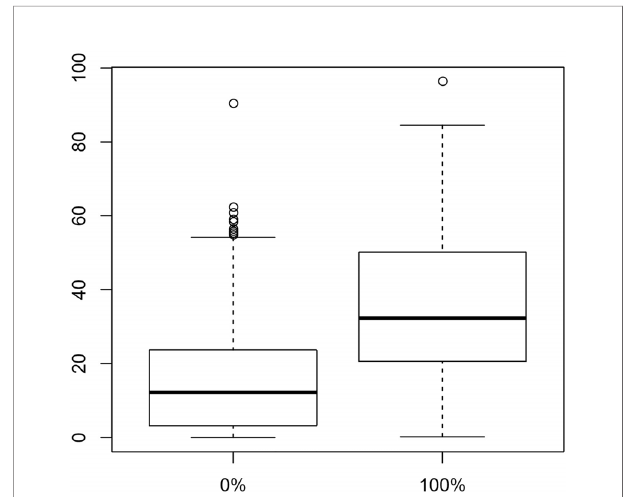
FIGURE 4 | Boxplots of the mean mutant fractions for neighbors in the x , y and z directions of spots with 0 and 100% mutant fractions show a signi fi cant difference. Spots carrying the mutation have neighbors with higher mutant fractions. Wilcoxon ’ s two-sample test gives a p-value of 2.2 × 10 -16 in favor of unequal local averages around the two types of central